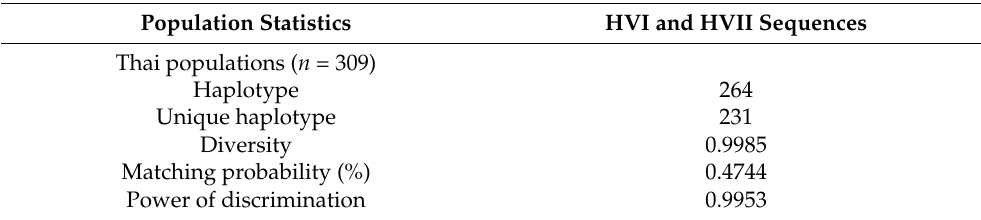
Table 1. Summary statistics for the Thai population for two mtDNA regions historically targeted for forensic typing. Population Statistics HVI and HVII Sequences Thai populations ( n =